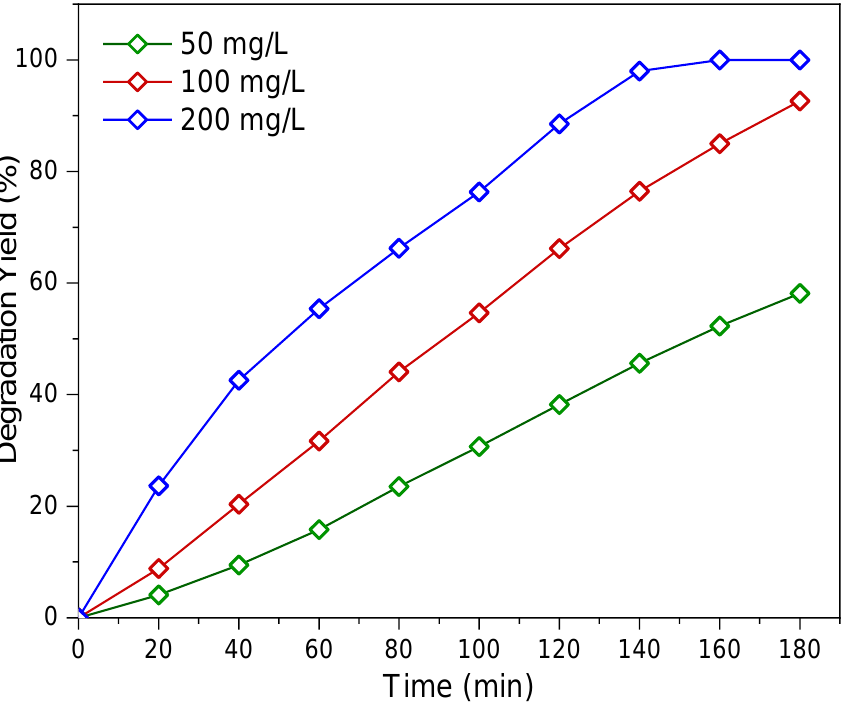
Figure 6. Effect of catalyst dosage in the photodegradation of BPB solution (10 ppm), natural pH, under UV irradiation.